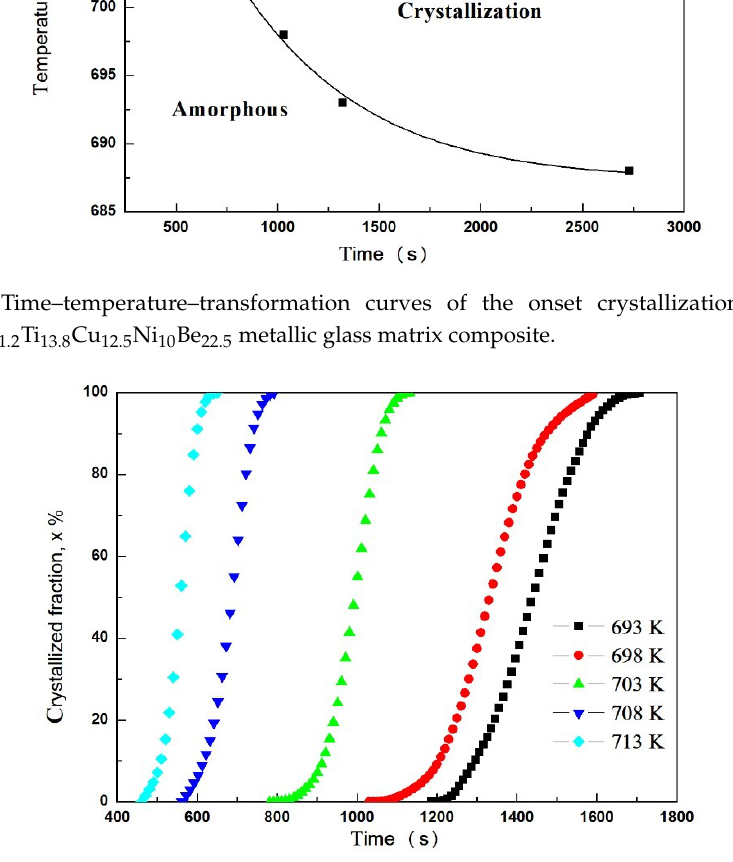
Figure 8. Crystallization volume fraction as a function of holding time at different temperatures for the W particles/Zr 41.2 Ti 13.8 Cu 12.5 Ni 10 Be 22.5 metallic glass matrix composite.